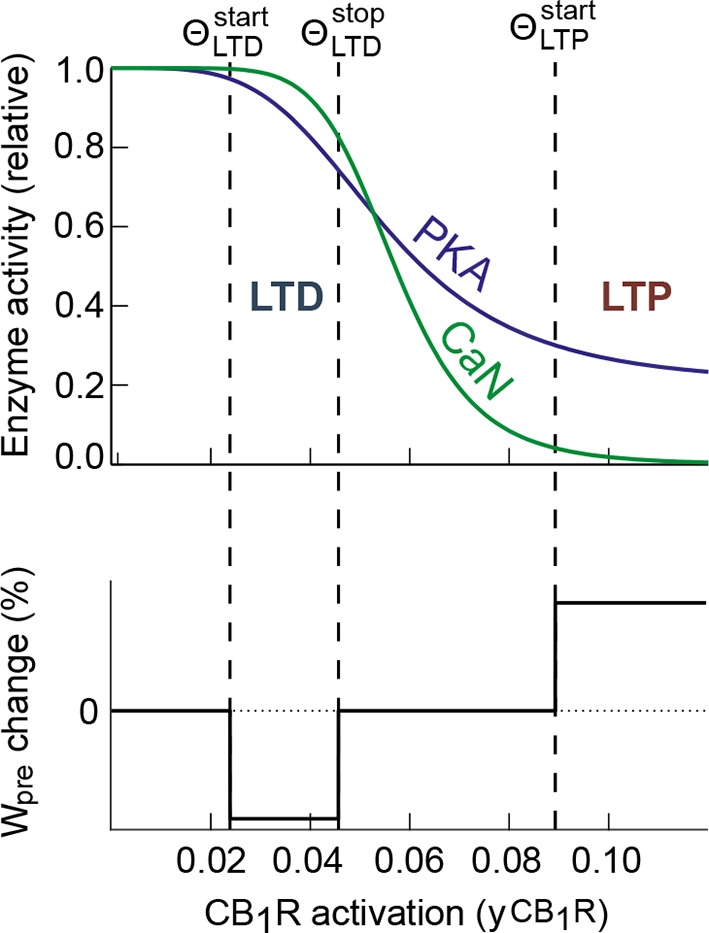
Schematic of a possible mechanism for PKA-CaN control of
eCB-dependent bidirectional STDP.CB1R is a Gαi GPCR which activation by eCB reduces the
activity of PKA. In the striatum, CB1R activation also inhibits
presynaptic VSCC, which is expected to reduce presynaptic calcium and,
potentially, calcium-activated calcineurin. Therefore, CB1R activation
may reduce both PKA and CaN activity. The top panel
gives a schematic illustration of this effect in a case where the kinetic
parameters are such that the ratio between PKA and CaN activity changes
when CB1R activation increases: CaN/PKA > 1 for intermediate CB1R
activation and switches to CaN/PKA < 1 for large activation. Our
experimental data for eCB-dependent STDP and its control by CB1R
activation (bottom) are compatible with the hypothesis
that eCB-LTD would be expressed when CaN/PKA > 1 whereas CaN/PKA <
1 leads to eCB-LTP.